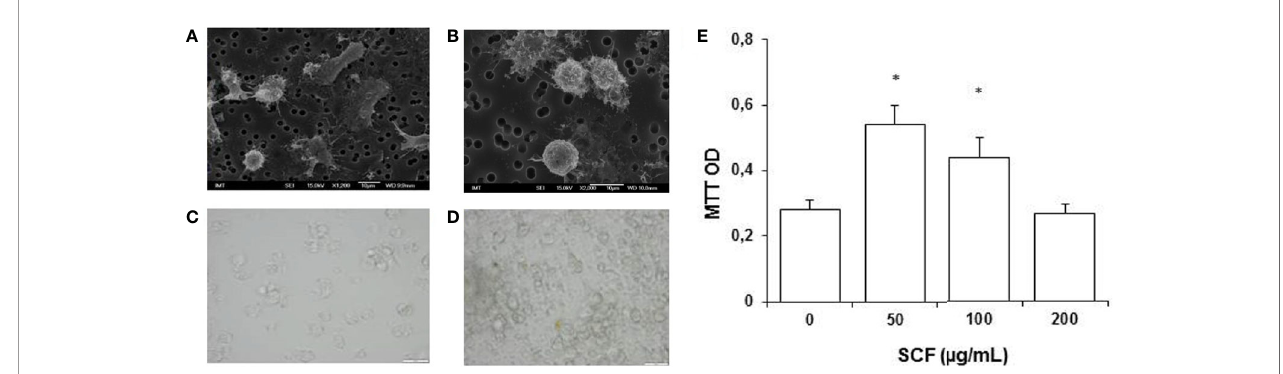
FIGURE 8 | Mytilus galloprovincialis . (A, B) Scanning electron microscopy (SEM) image of freshly isolated cells (courtesy of Dr. Manon Auguste). (C, D) Light microscopy of control hemocytes (C) and hemocytes exposed to human Stem Cell Growth Factor (SCF) (24 h, 50 µg/mL, in the presence of 5 µg/mL Con-A (D) . (E) Effects of SCF on hemocyte proliferation evaluated by the MTT assay. *P < 0.05 Mann-Whitney